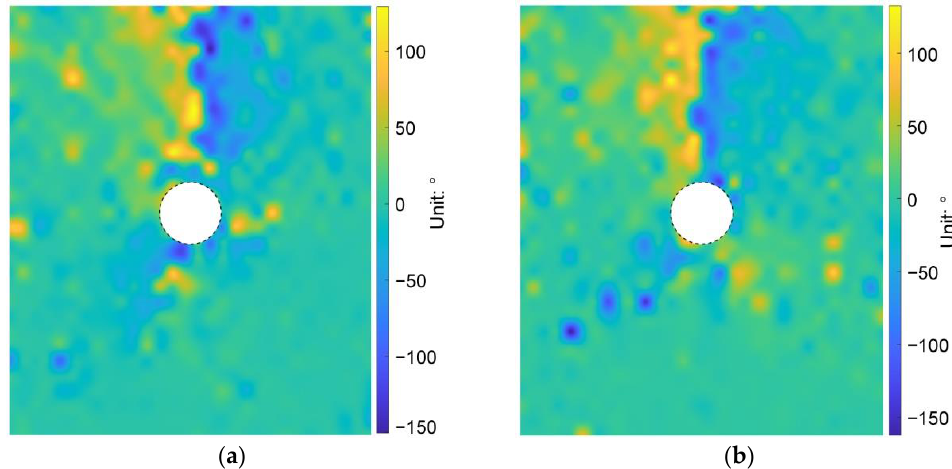
Figure 28. Particle rotation after the tunnel excavation in the cases of ( a ) AR2C1 and ( b ) AR2C2. Refer to Figure 12 for the legend.